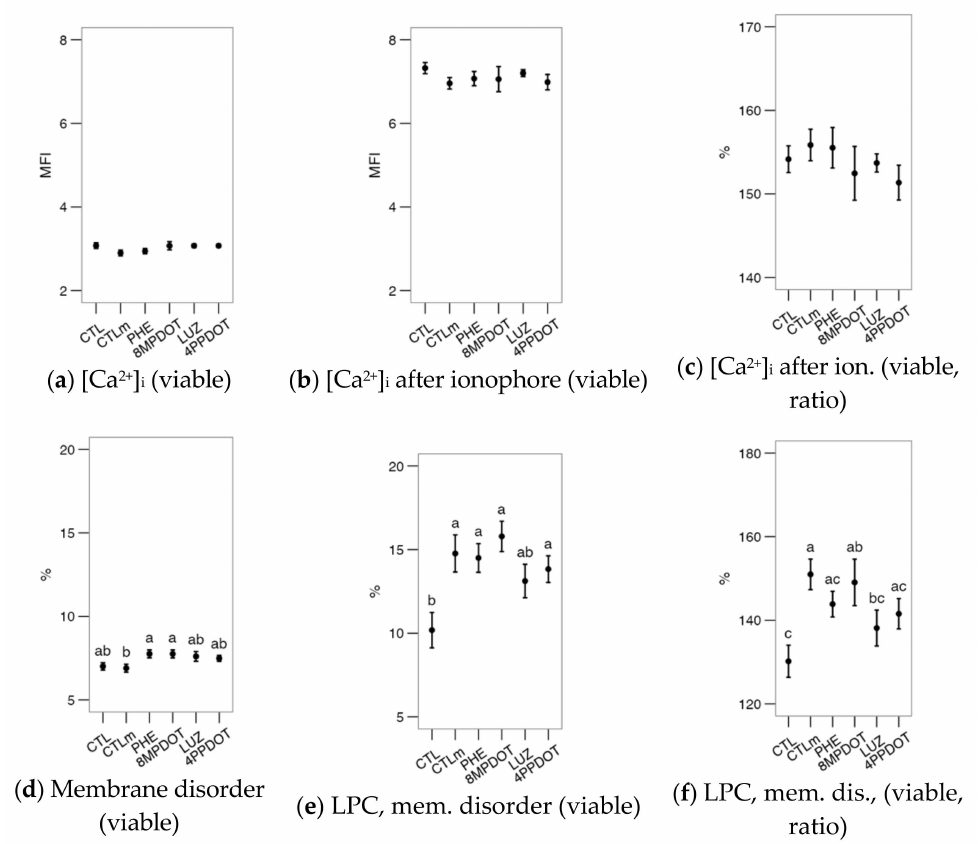
Figure 2. Effects on bull sperm intracellular calcium ([Ca 2+ ] i ) and membrane lipidic disorder (within the viable population) of melatonin receptor agonists (PHE: Phenylmelatonin; 8MPDOT: 8-Methoxy- 2-propionamidotetralin) or antagonists with 10 nM melatonin (LUZ: Luzindole; 4PPDOT: cis-4- Phenyl-2-propionamidotetralin); CTL: Control; CTLm: Control with 10 nM melatonin. Plots show mean ± SEM for each treatment of seven males. ( a ) Intracellular calcium concentration ([Ca 2+ ] i, from mean fluorescence intensity of Fluo-4 in viable spermatozoa); ( b ) Same parameter after ionophore treatment and ( c ) as ratio of the values after ( b ) and before ( a ) the challenge; ( d ) Proportion of cells with increased membrane disorder in the viable population (PI − ) as M540 + and ( e ) the same parameters after lysophosphatidylcholine (LPC) treatment, and ( f ) as ratio of the values after ( e ) and before ( d ) the challenge. Treatments not sharing the same letters differ significantly ( p <